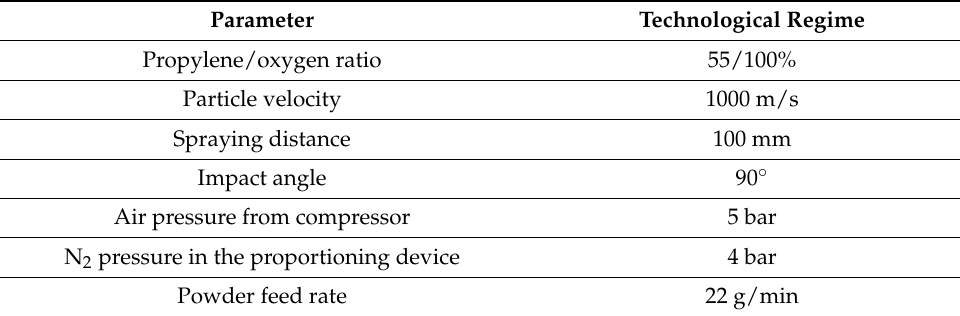
Table 2. Technological regime parameters for HVOF coating